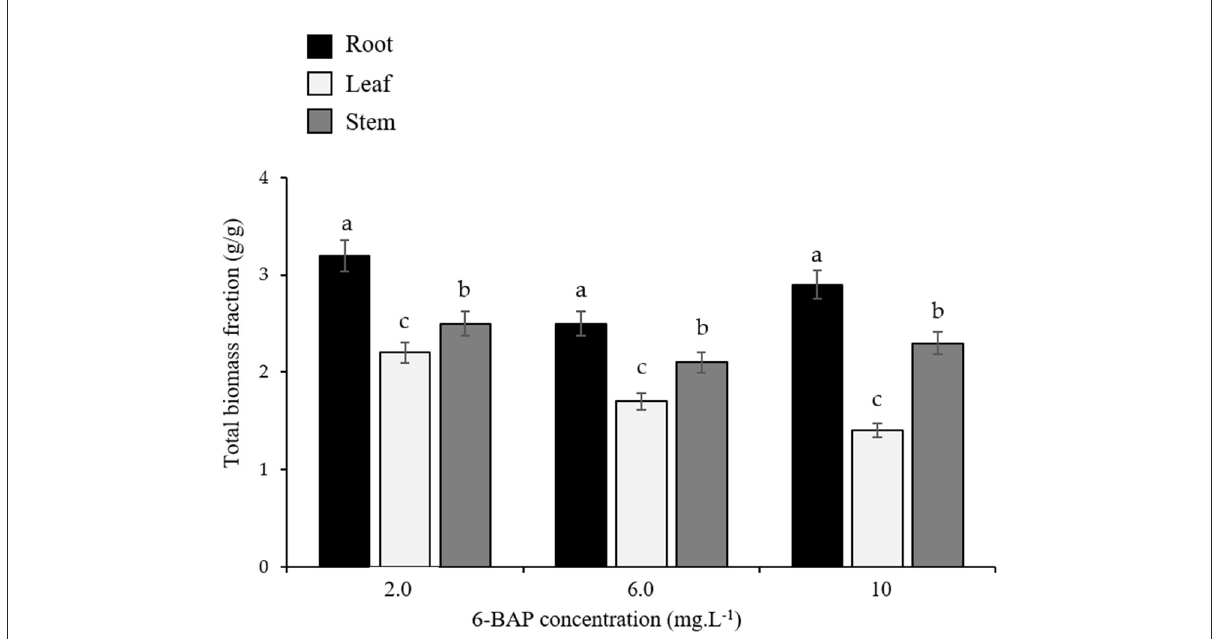
FIGURE3 Variations in total biomass fractions of root, stem, and leaf following seed priming (16h) with different concentrations of 6-BAP (Mangena, 2020).